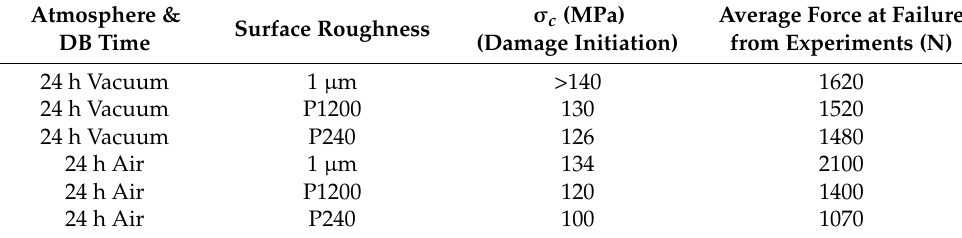
Table 8. Interface strength characterized from the numerical